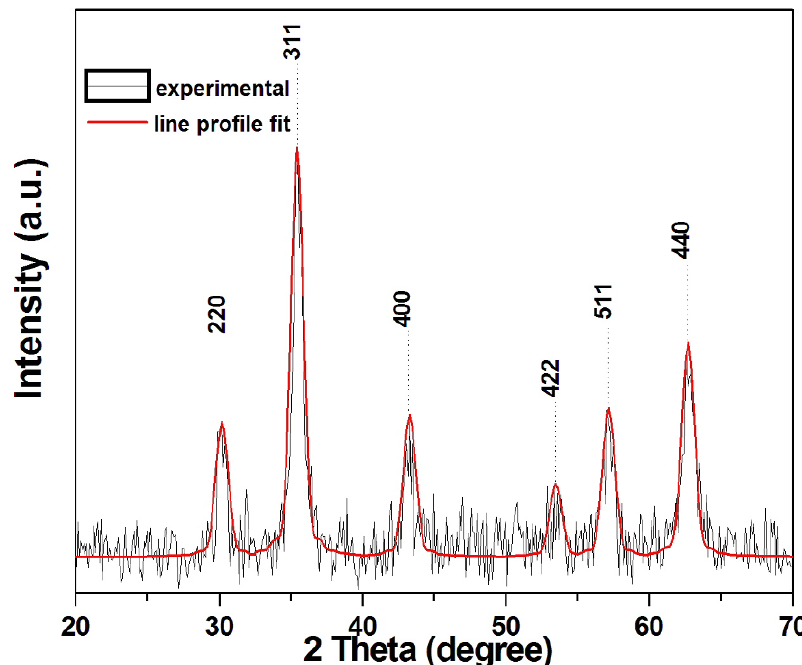
Figure 3. (cid:59)(cid:53)(cid:39)(cid:3)(cid:83)(cid:82)(cid:90)(cid:71)(cid:72)(cid:85)(cid:3)(cid:83)(cid:68)(cid:87)(cid:87)(cid:72)(cid:85)(cid:81)(cid:3)(cid:68)(cid:81)(cid:71)(cid:3)(cid:79)(cid:76)(cid:81)(cid:72)(cid:3)(cid:83)(cid:85)(cid:82)(cid:287)(cid:79)(cid:72)(cid:3)(cid:287)(cid:87)(cid:87)(cid:76)(cid:81)(cid:74)(cid:3)(cid:82)(cid:73)(cid:3)(cid:51)(cid:57)(cid:44)(cid:74)(cid:48)(cid:49)(cid:51)(cid:17) Table 1. Sample abbreviations for the nanocomposite polymer electrolytes.